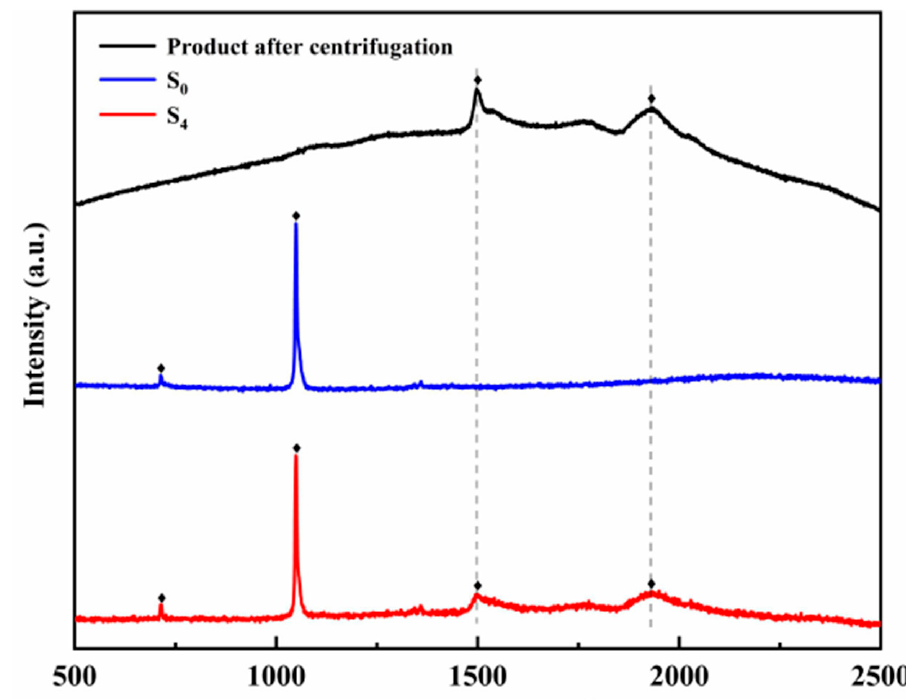
Figure 3. The Raman spectra of samples S 0 , S 4 , and product after centrifugation.